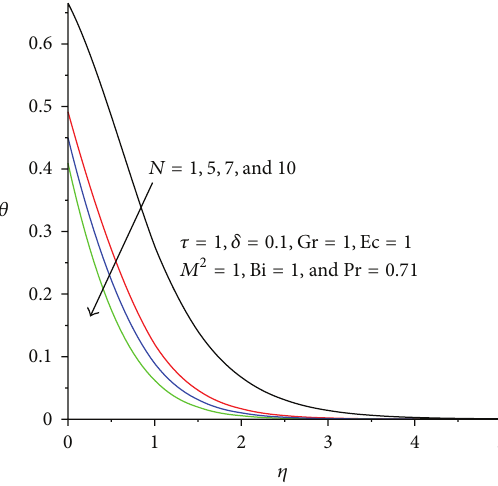
Figure 13: Temperature profiles with increasing 𝑀 .